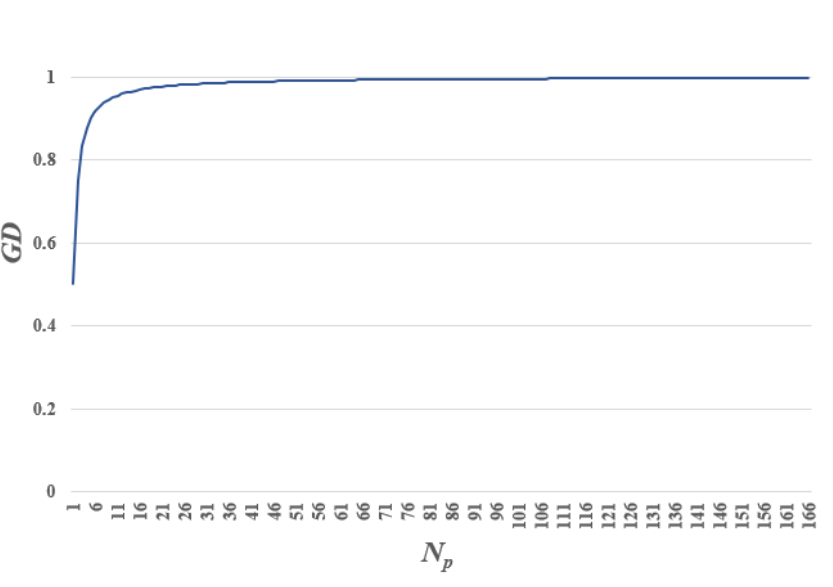
Figure 3. Relationship between effective number of parents ( N p ) and gene diversity ( GD ) in the P. orientalis clonal seed orchard . orientalis clonal seed